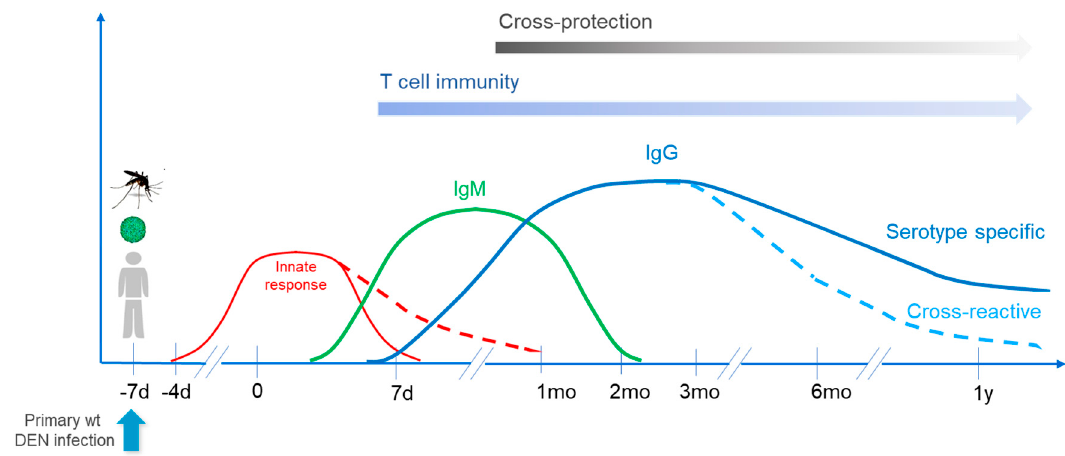
Figure 1. Upon primary wild type dengue infection, innate responses develop early and peak during the first week following onset of fever, while some responses can persist for several weeks. Dengue specific IgM responses develop first, followed by IgG. IgM responses usually wane after two months and IgG responses persist a longer time, while cross-reactive responses wane more rapidly. CD4 + and CD8 + T cell responses are also triggered during the early phase of infection, and T / B cell memory is then established. Induced responses support cross-protection (see below), which can last up to 3 years (more generally 6 months to 2 years). d: day; mo: month; y: year; wt: wild type.